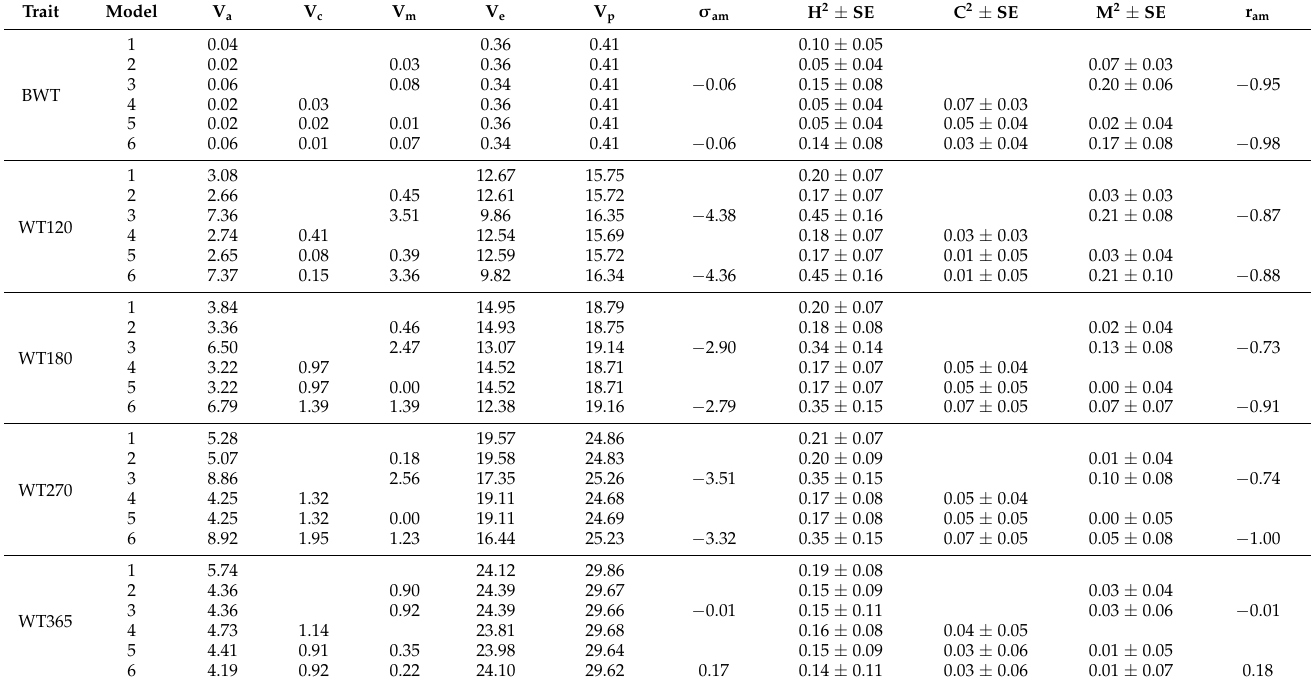
Table 5. Estimates of variance components and related parameters obtained from six different models for growth traits of Lohi